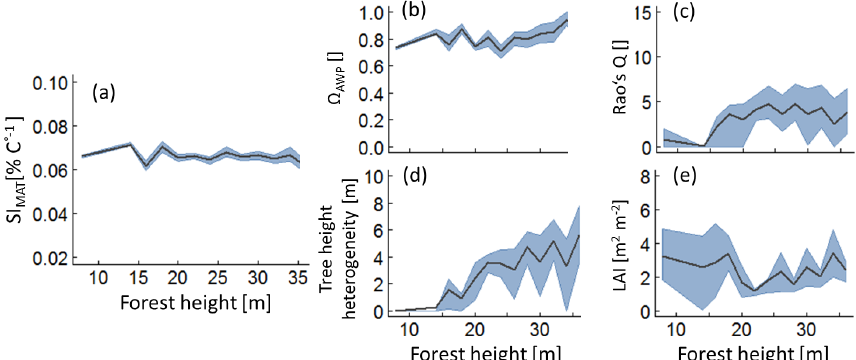
Figure 5. Analysis of those forests that show the highest 5% of the SI MAT values depending on forest height. Lines indicate mean values of the forest subsamples which include the best 5% with regard to SI MAT of each hight class. The grey band indicates the interquartile range. Panel (a) shows temperature sensitivity of aboveground wood production over forest height, analysing only the best the forest subsample. Panels (b) to (e) show the change of the remaining forest properties within the forest subsamples ( (cid:127) AWP is the optimal species distribution; LAI is the leaf area index; Rao’s Q quantifies functional